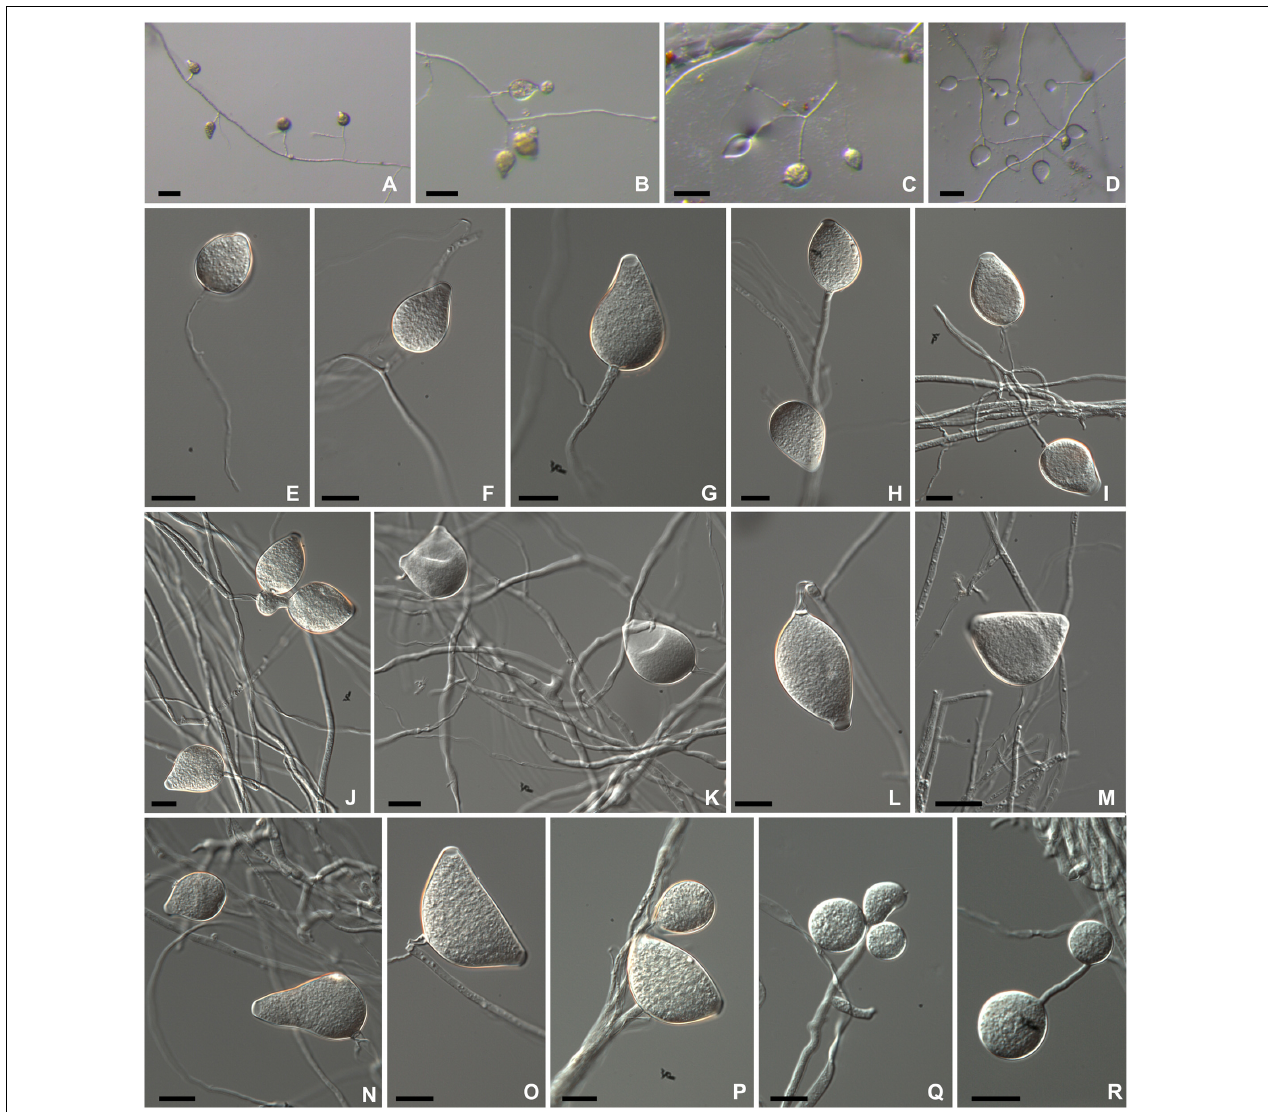
FIGURE 2 | Morphological structures of Phytophthora theobromicola isolate CCUB1091 formed on V8-juice-agar flooded with soil extract (A–D) and carrot-agar (E–P) . Sporangia borne on simple sporangiophores produced in non-sterile soil extract (A–D) . Subglobose to globose semipapillate sporangium (E) . Obpyriform papillate sporangia (F,G,I,J,L,N) . Ovoid semipapillate sporangia (H,K) . Turbinate bipapillate sporangia (M,O,P) . Globose chlamydospores produced on water-agar (Q–R) . Bars: panels (A–D) = 500 µ m; panels (E–R) = 20 µ